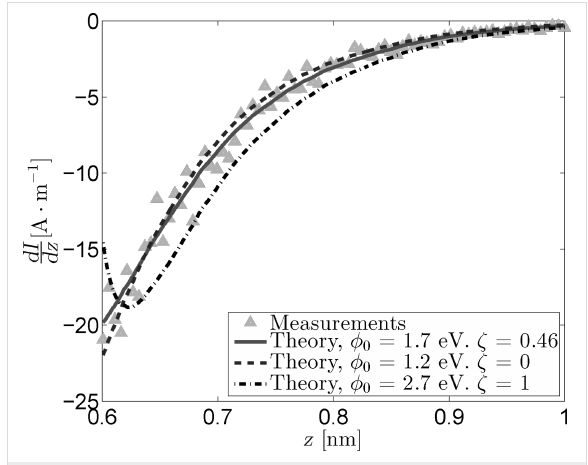
Figure 1: Measured and reconstructed dI / dz data obtained from I ( z ) measurements using three sets of fit parameters. The results for the “free” fit and the fit in absence of an image charge strongly resemble one another, indicating a masking interaction between and ζ